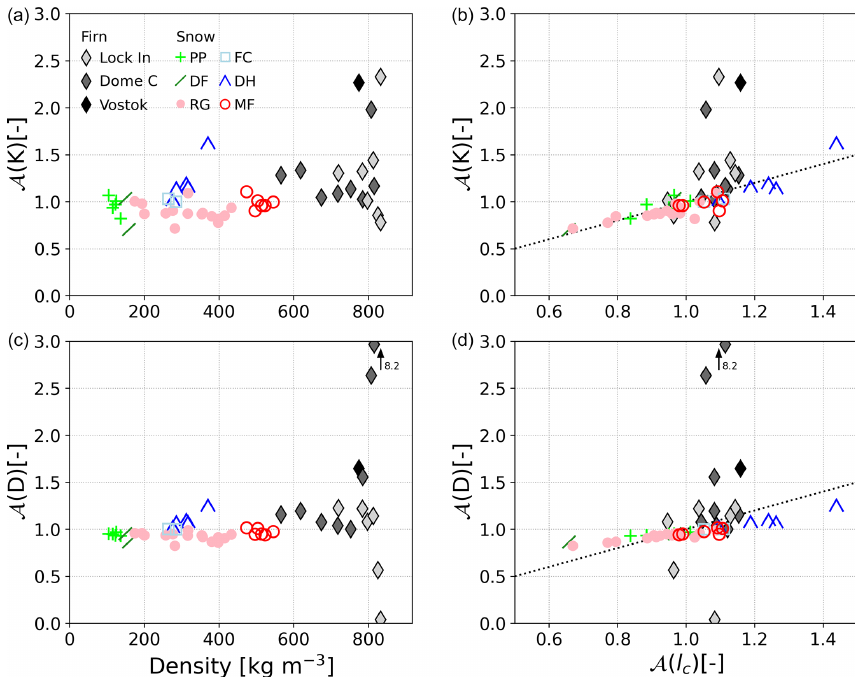
Figure 4. Relationships of the anisotropy ratio of the permeability tensor A (K) (a, b) and of the diffusion coefficient tensor A (D) (c, d) with density and structural anisotropy A (l c ) . The arrows indicate a value of A (D) of 8.2 at a density of 832kgm − 3 for a firn sample from Lock In. Dotted lines indicate 1 : 1